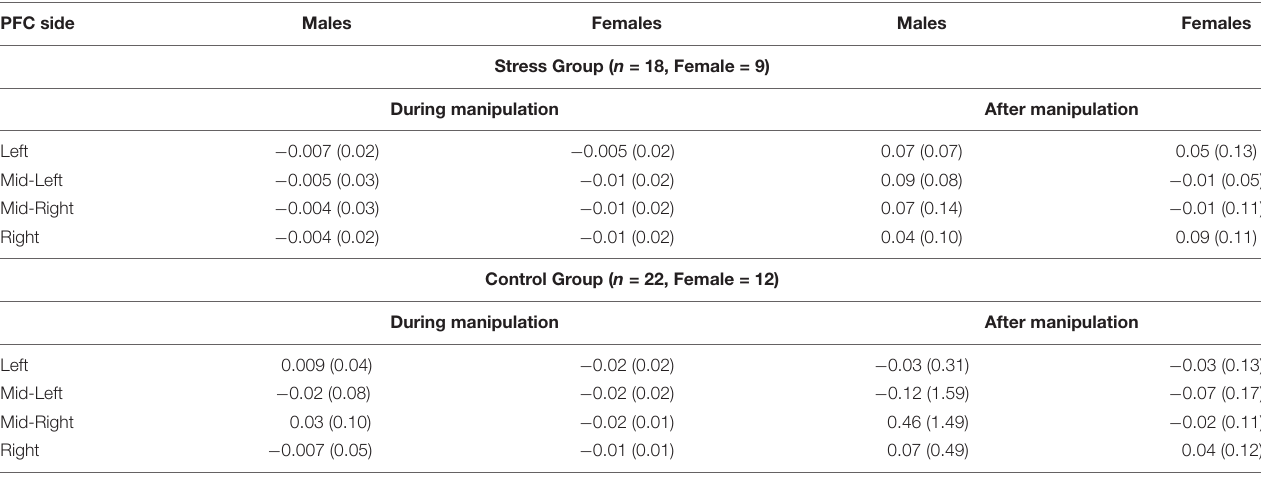
TABLE 3 | Mean values and SDs (in parentheses) for sex differences in hemodynamic activity during and after manipulation per group (Stress or Control) across all participants. PFC side Males